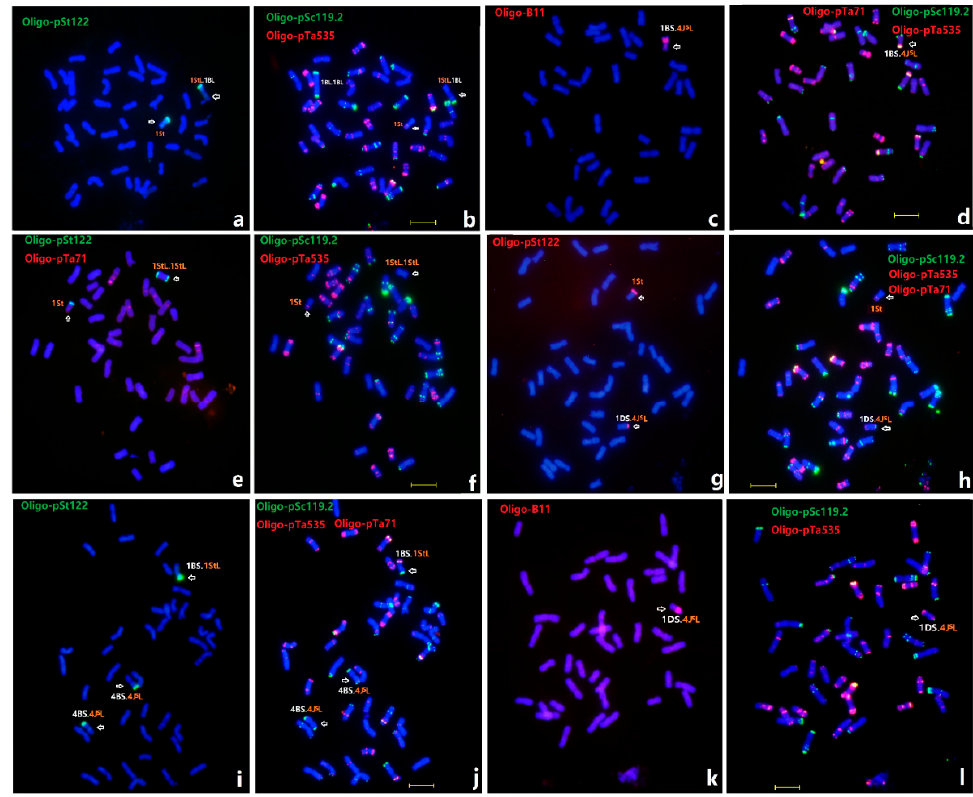
Figure 2. Sequential ND-FISH of F 2 progenies of hybrids between X479 and MY11. The lines C423 ( a , b ), C32 ( c , d ), C451 ( e , f ), C429 ( g , h ), C436 ( i , j ), C460 ( k , l ) were indicated. The arrows indicated the introgressed Thinopyrum or wheat- Thinopyrum translocation chromosomes. Bars, 10 μ m.